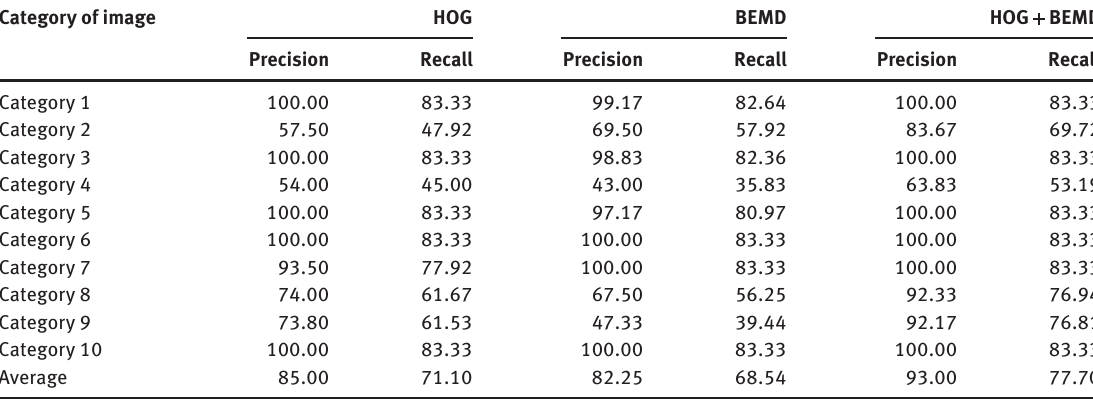
Table 1: Precision and Recall Values for the Existing and the Proposed System.